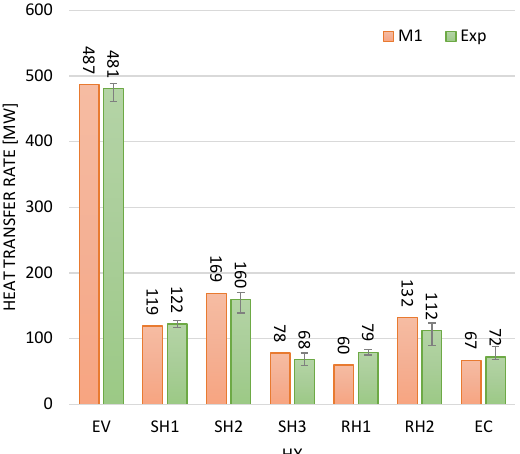
Figure 9. Calculated (M1) and measured heat transfer rates per heat exchanger for the utility-scale coal-fired boiler 80% load case. Table 5. Direct method and projected method heat transfer rate results for 100% MCR coal-fired boiler case